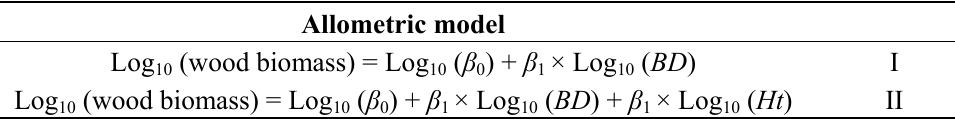
Table 3. The allometric models fitted on the